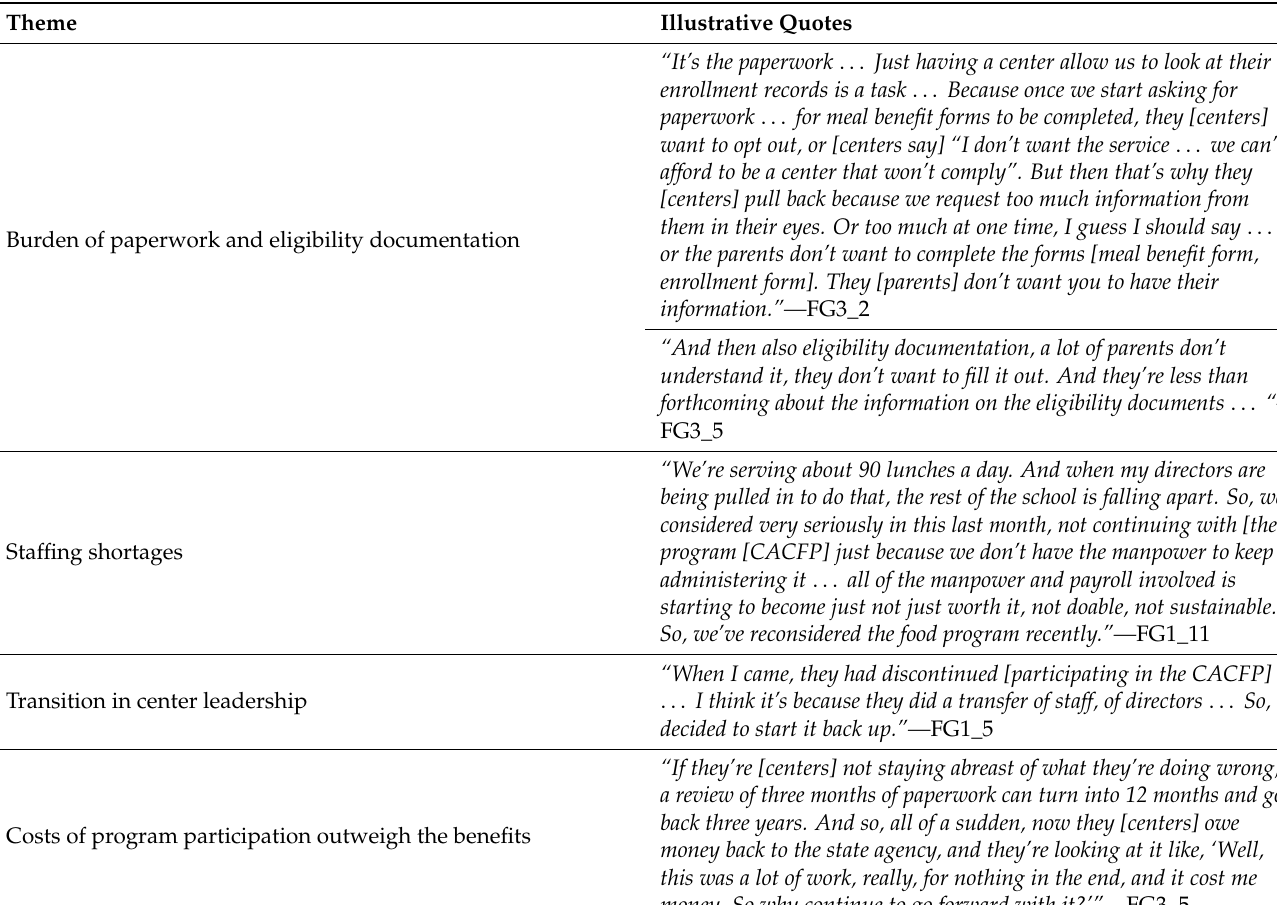
Table 6. Emergent themes of reasons why some independent centers do not participate in the CACFP or have left the program 1